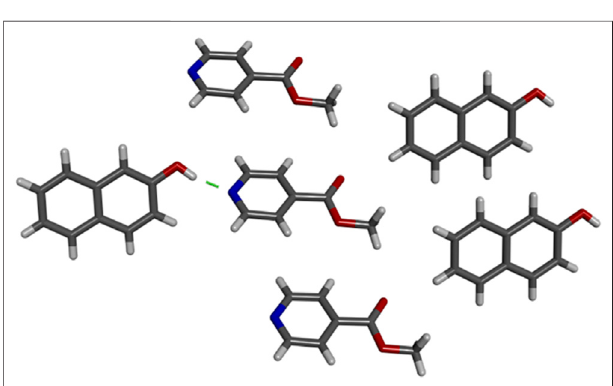
FIGURE 10 | Crystal structure of 2NO · MI grown from methanol. Hydrogen bond shown with green dashed